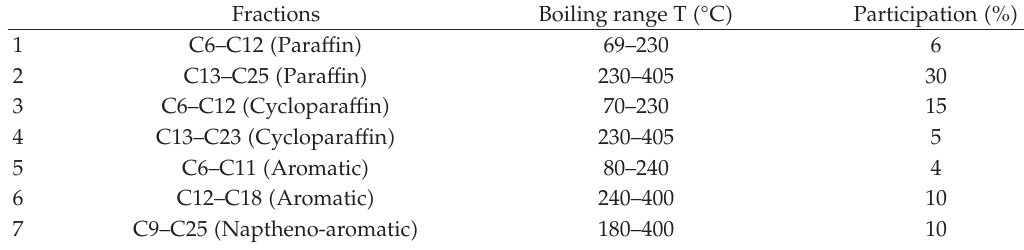
Table 1: Oil fractions, divided by the chemical composition and distillation characteristics (cid:6) 35 (cid:7) , used in the numerical simulations.